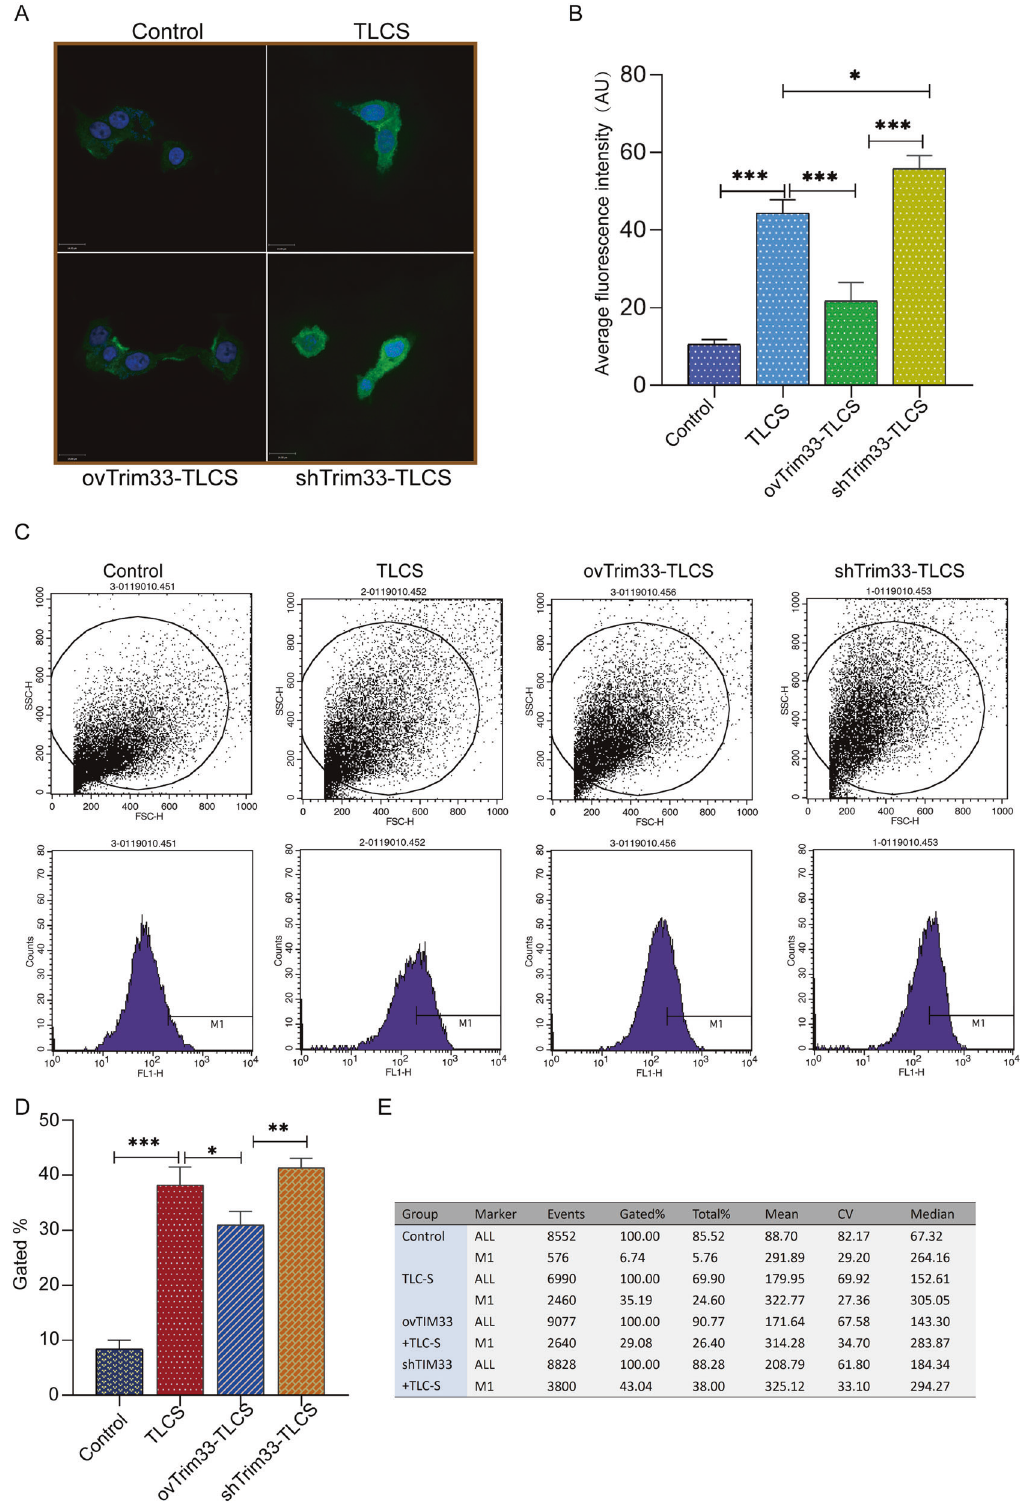
Fig. 3 Trim33 can reduce activated trypsinogen. A BZiPAR fl uorescent substrate method detected the activation of trypsinogen in each group. Green represents BZiPAR, and its fl uorescence intensity represents activated trypsinogen, while blue is the cell nucleus (DAPI). B The average fl uorescence intensity value of each group. C , D Flow cytometry to detect the fl uorescence intensity value of each group. E The fi gure counts the number (Events) and proportion (Gated%) of BZiPAR-stained cells (M1) in each group. ( t -test; *** p < 0.001, ** p < 0.01, * p < 0.05).